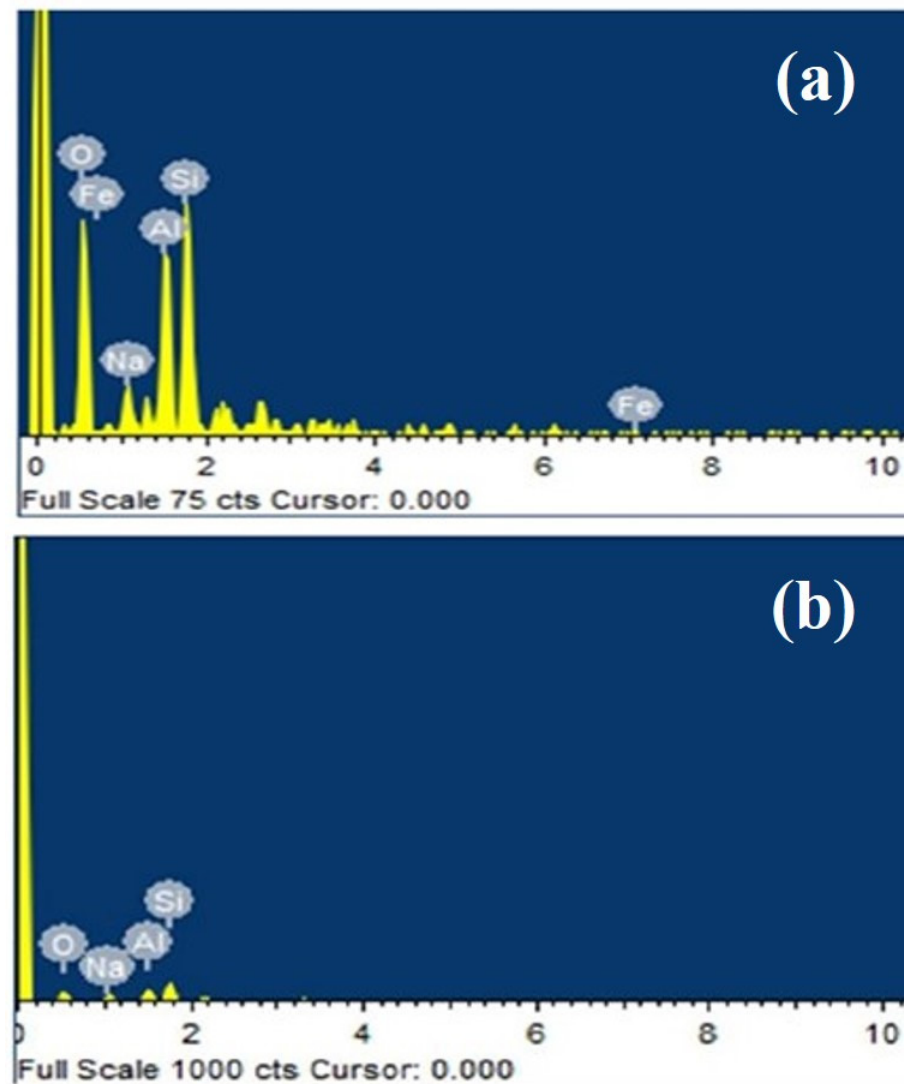
Figure 2. Energy-dispersive X-ray spectroscopy (EDX) of Fe-Zeolite ( a ) and zeolite without iron coating ( b